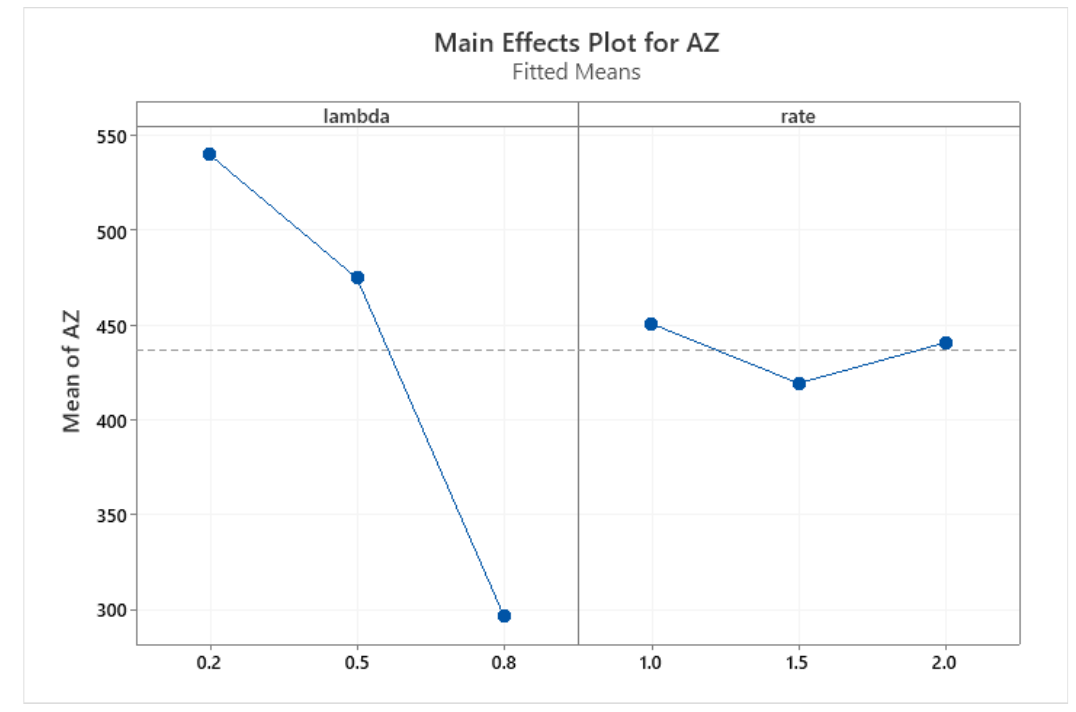
Figure 17. Marginal means plot for AZ hardness with respect to the lambda (share of AISI316L) and rate (speed of alloying) explanatory variables.